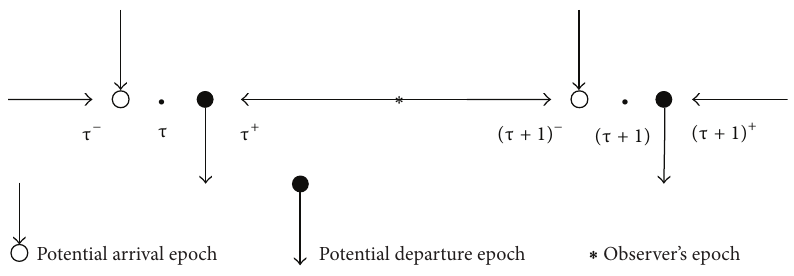
Figure 2: Various time epochs in this late arrival system with delayed